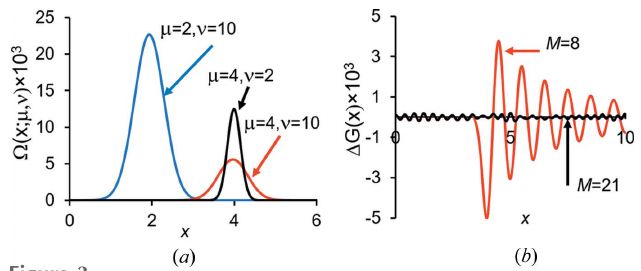
Figure 3 Shell decomposition of the interference function. ( a ) Radial component of the function (cid:2) ( x ; (cid:5) , (cid:6) ) with different (cid:5) and (cid:6) values indicated on the plot. ( b ) Radial component of the difference between the left and right sides in the decomposition (8) for different numbers M of the terms